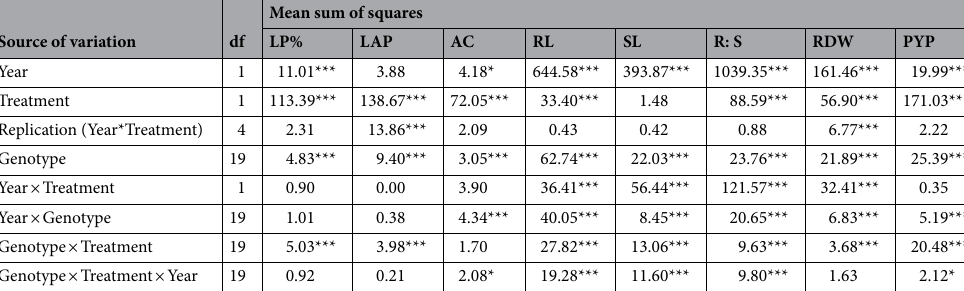
Table 2. Pooled ANOVA (F value) for phosphorus related and yield traits in groundnut. *: significant at < 0.05, **: significant at < 0.01, ***: significant at < 0.001 probability level. df—Degrees of freedom, LP%—Leaf phosphorus (%), LAP—Leaf acid phosphatase (µM/hr/gm), AC—Anthocyanin content (mg/g), RL—Root length (cm), SL –Shoot length (cm), R: S—Root: Shoot ratio, RDW—Root dry weight (g), PYP—Pod yield per plant (g).